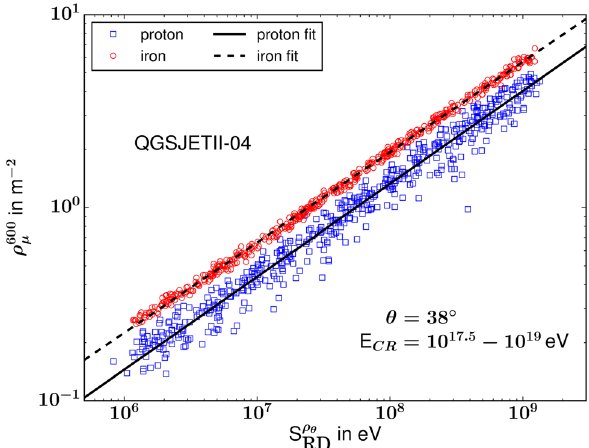
Fig. 10 Ratio between the muon density and the square root of the radiation energy compared to the zenith angle. The separation of proton andironshowersexceedsthespreadoriginatingfromshower-to-shower fluctuations.Theratiodecreasesforlargerzenithangles,sincethemuon density decreases (cf. Fig.